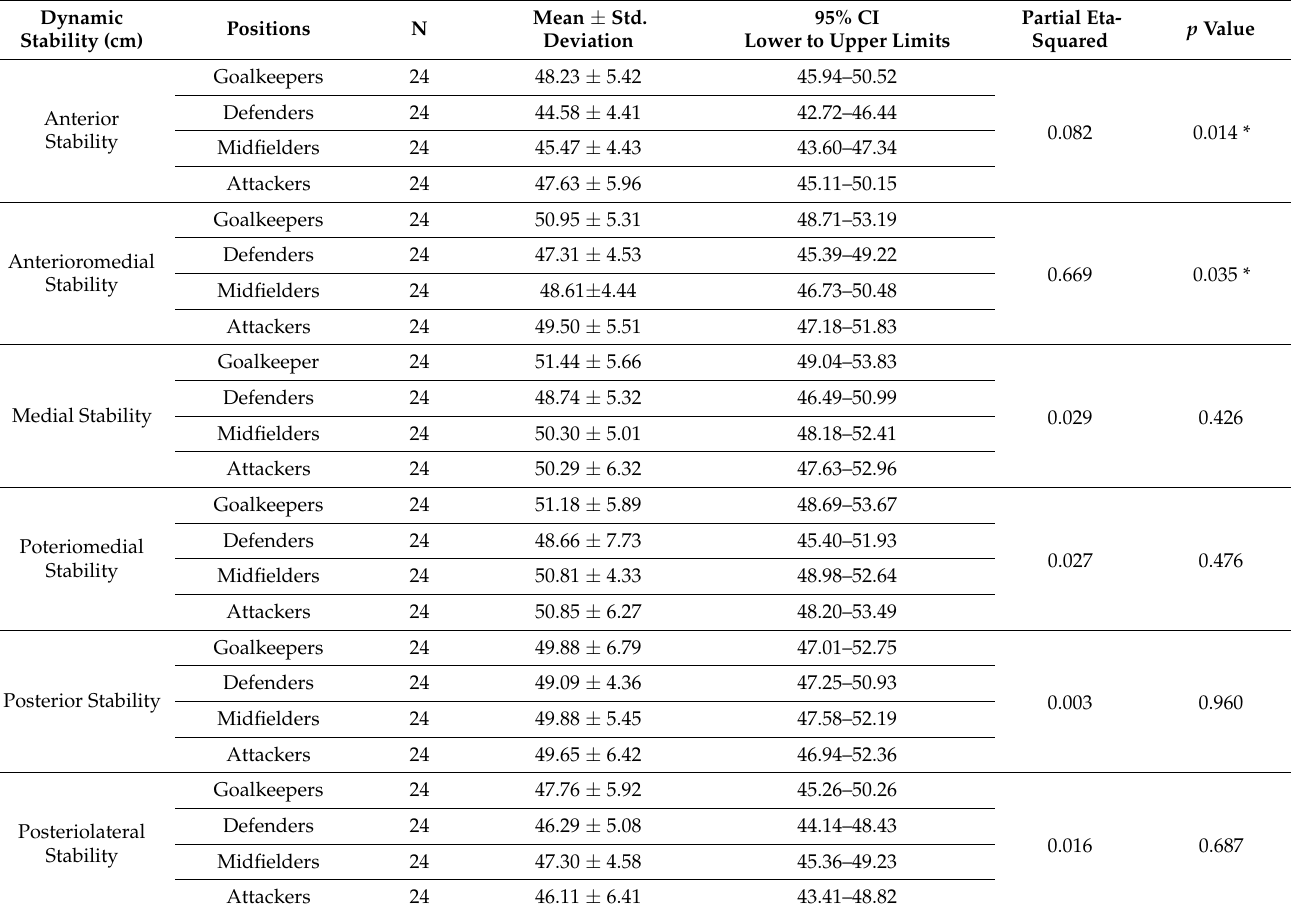
Table 4. Statistical analysis of variance of dynamic stability values of soccer players for their playing